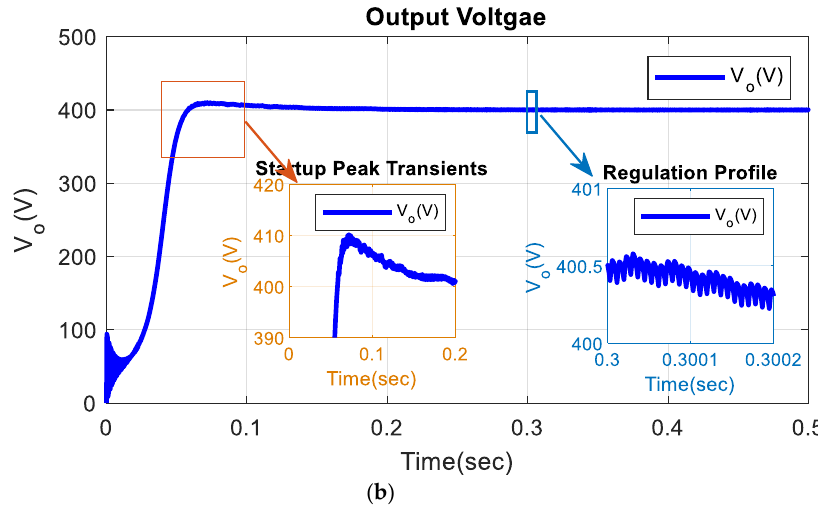
Figure 14. Measurements of the module and output voltages in the converter. The converter’s efficiency for input voltages ranged from 40 V to 100 V in 20 V steps. The output power varied from 200 W to 3.6 kW in 200 W intervals (note that the higher input voltage allowed the converter to operate at higher output power). The converter’s efficiency was measured to be 92.8 percent at the nominal operating point. A positive step change in load was introduced in the converter, with the load varying from 500 W to 1000 W, the result of which is shown in Figure 15. Figure 16 shows the reverse step load shift, with the load changing from 1000 W to 500 W.